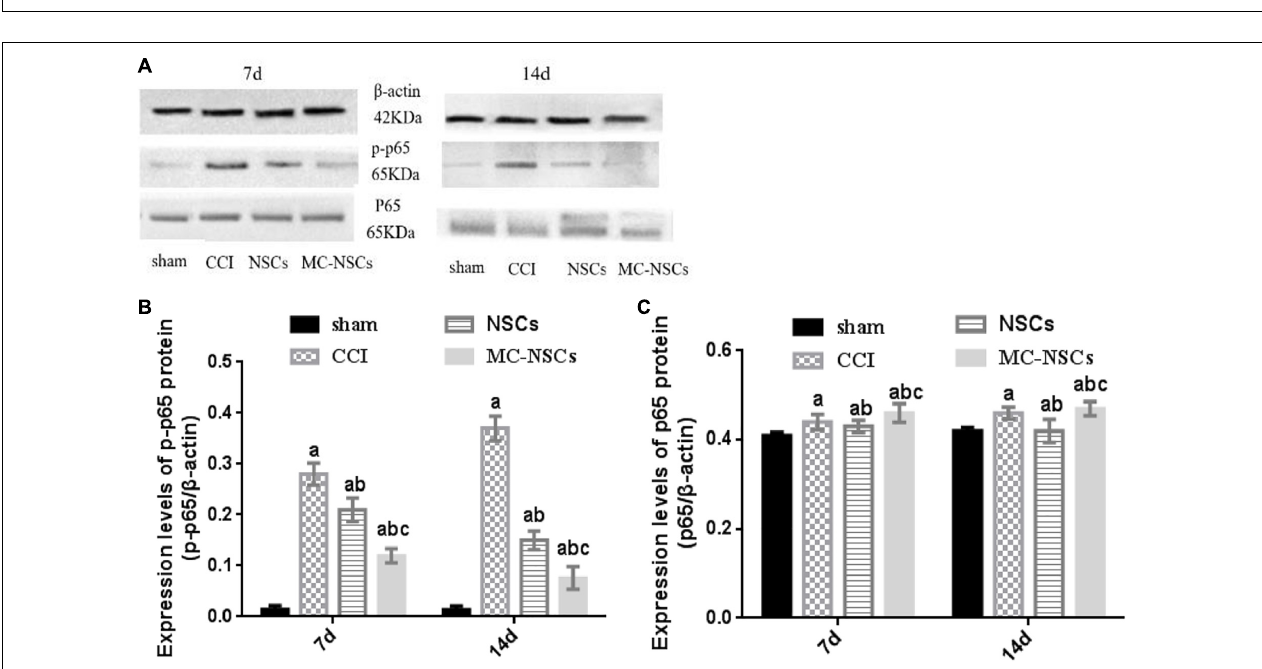
FIGURE 7 | Results of IL-1 β and TNF-a concentrations in serum by ELISA. (A,B) The concentrations of IL-1 β and TNF-a in serum of rats from high to low were found in the CCI, NSCs, MC-NSCs, and sham groups. Compared with the NSCs group, the concentrations of IL-1 β and TNF-a in the MC-NSCs group were reduced ( p < 0.05). Data were expressed as the mean ± SD of three replicates ( n = 6). a p < 0.05 vs. sham group; b p < 0.05 vs. CCI group; c p < 0.05 vs. NSC group.